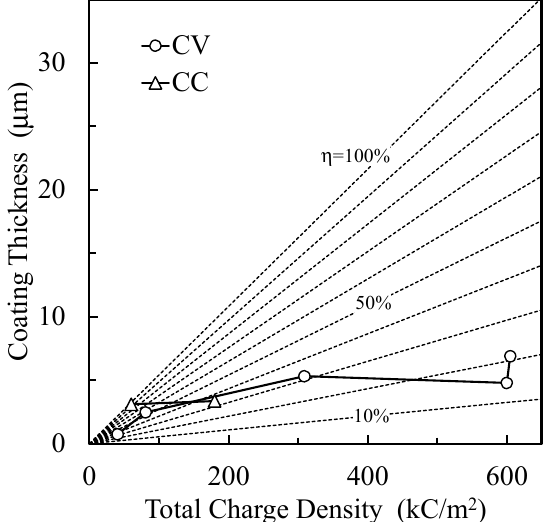
Figure 13. Coating thickness dependence on the total charge density by CV and CC operations and Faraday’s model with different utilization efficiency of total charge density.